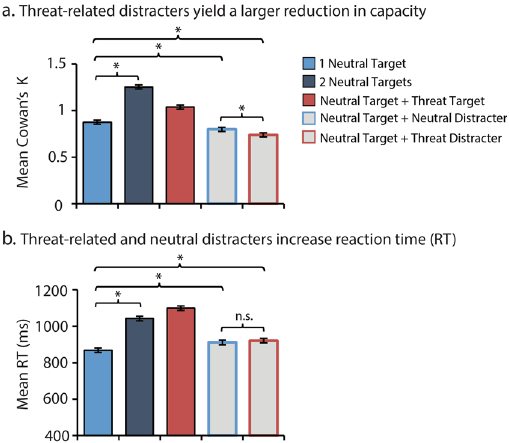
Figure 5. Influence of load and distracters on behavior. ( a ) WM capacity ( K ) scales with load and is reduced by distracters. Trials with a threat-related distracter (Neutral Target + Threat Distracter) were associated with a greater reduction in storage capacity than trials with a neutral distracter (Neutral Target + Neutral Distracter) ( b ) Reaction time (RT) scales with WM load and is increased by both threat and neutral distracters to a similar degree. Asterisks indicate p < 0.05. Error bars indicate the nominal probability of the null hypothesis being rejected by chance: p < 0.05 (non-overlapping bars) or p > 0.05 (overlapping bars) and were computed as described in ref.